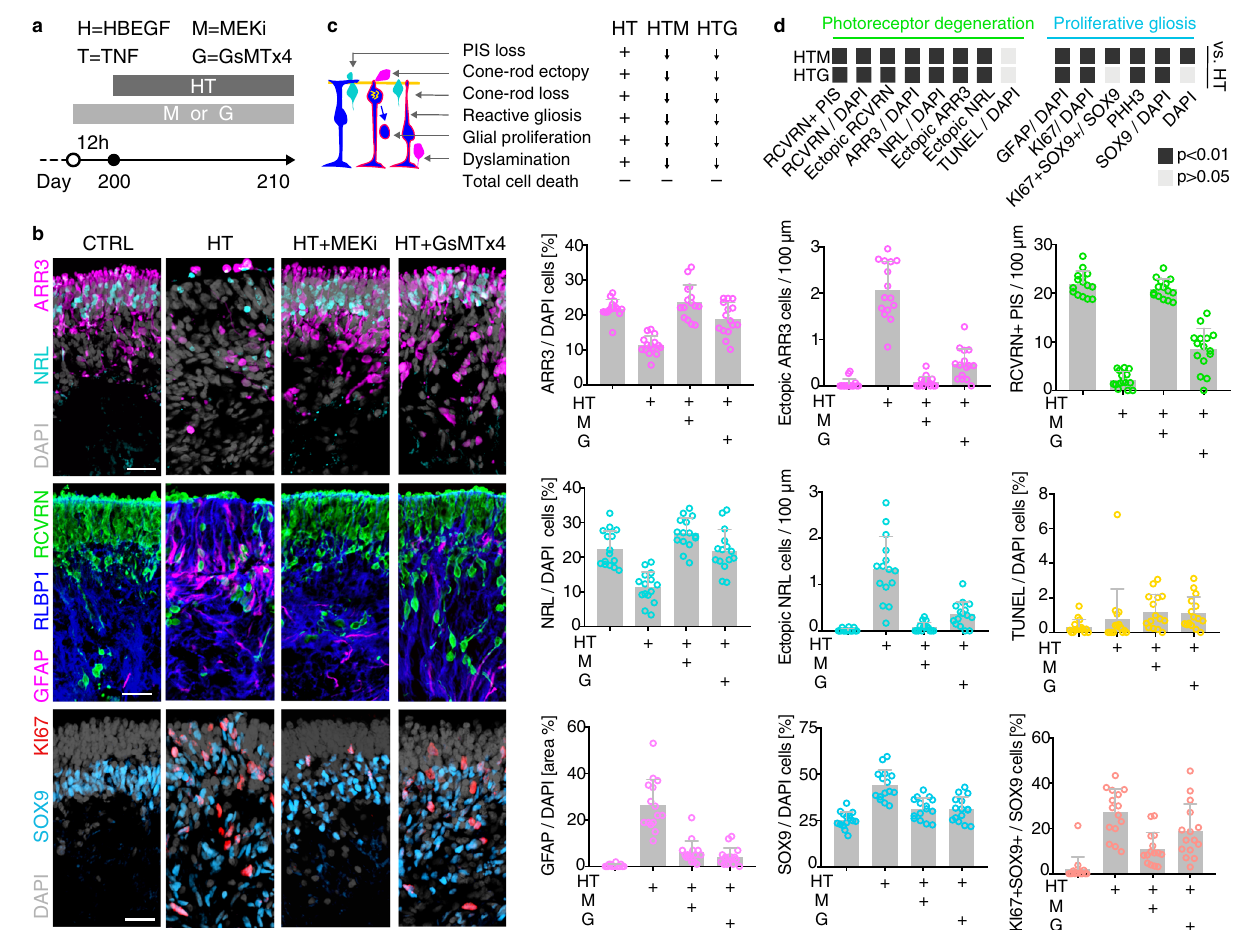
Fig. 8 | Pharmacological MEK or PIEZO1 inhibition attenuates photoreceptor andglialpathologiesintheHT-HROmodel.a Experimentaldesign:startingfrom day200,HROswereculturedfor10dayswithHTtreatmentorwithout.Aselective inhibitor(MEKi;U0126) ofMAPkinase kinases(MEK1 andMEK2), known to inhibit MAPK activation, or GsMTx4, an inhibitor of PIEZO1 and other mechanosensitive ion channels, were added to HROs starting 12h before HT application, and throughout the HTtreatment period. b Representative ROI images recordedfrom immunostained serial HRO sections, and quantitative analysis to determine the effect of the pharmacological inhibitors on the HT-HRO phenotype, including retinal cell-type composition, pathologic changes of photoreceptor inner